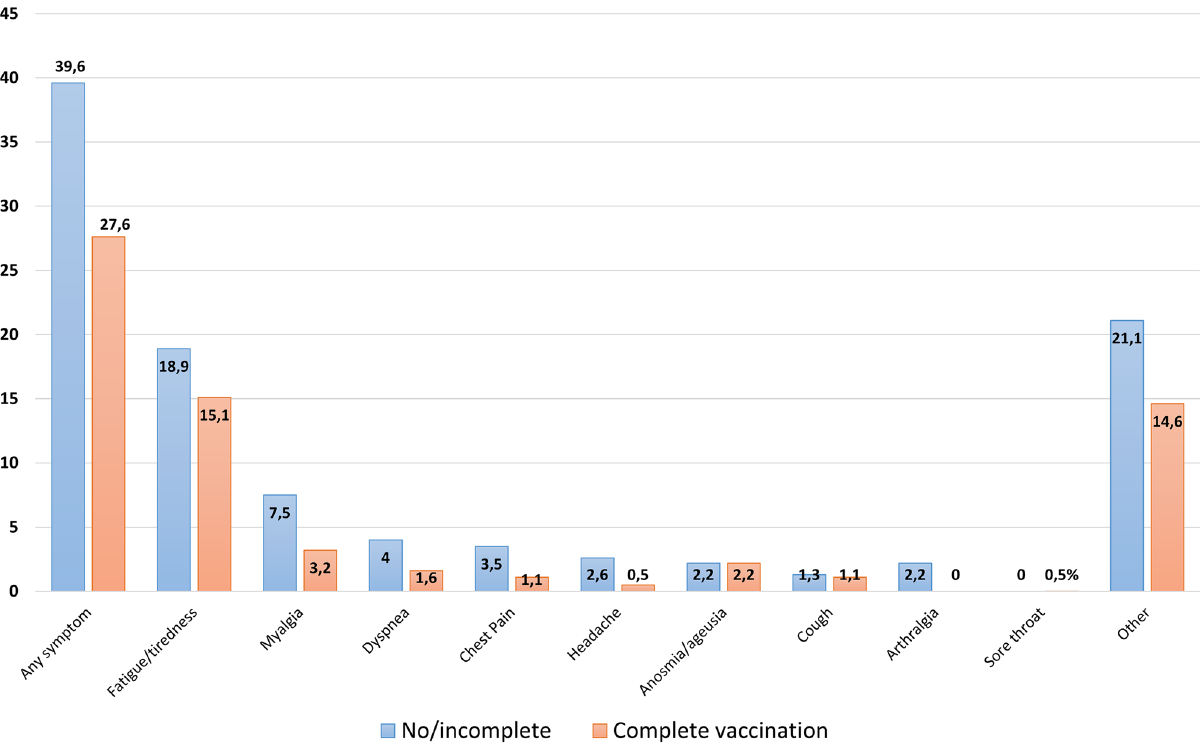
Figure 1. The frequency ( A ) and number of symptoms reported by patients according to vaccination